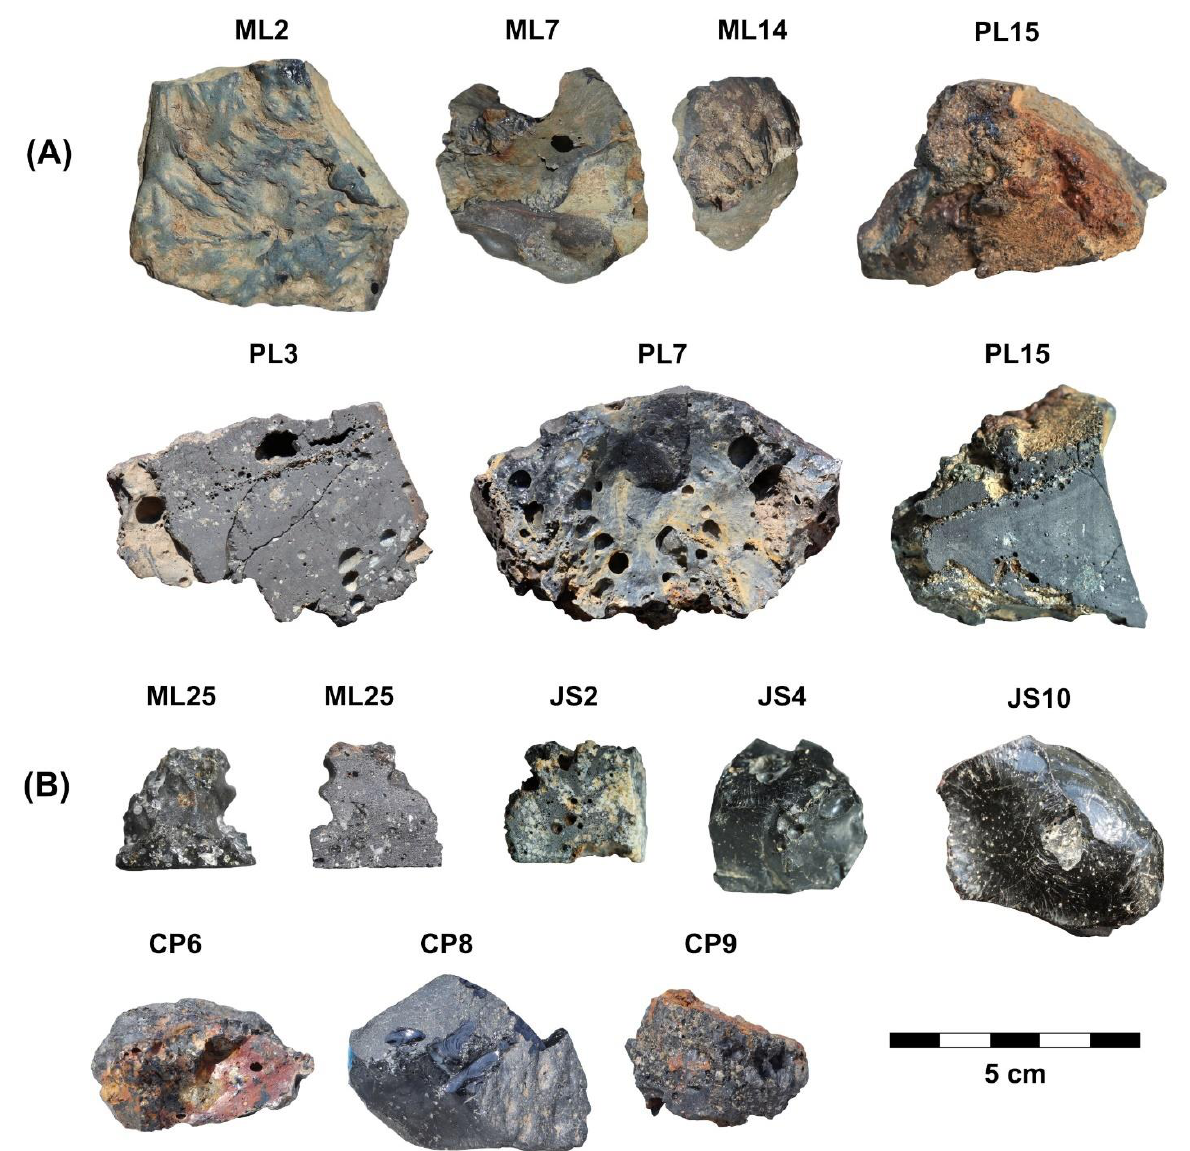
Figure 2. Macrophotographs of Type ( A ) slags from Sites 1 and 2 and Type ( B ) slags from Sites 2, 3, and 4.